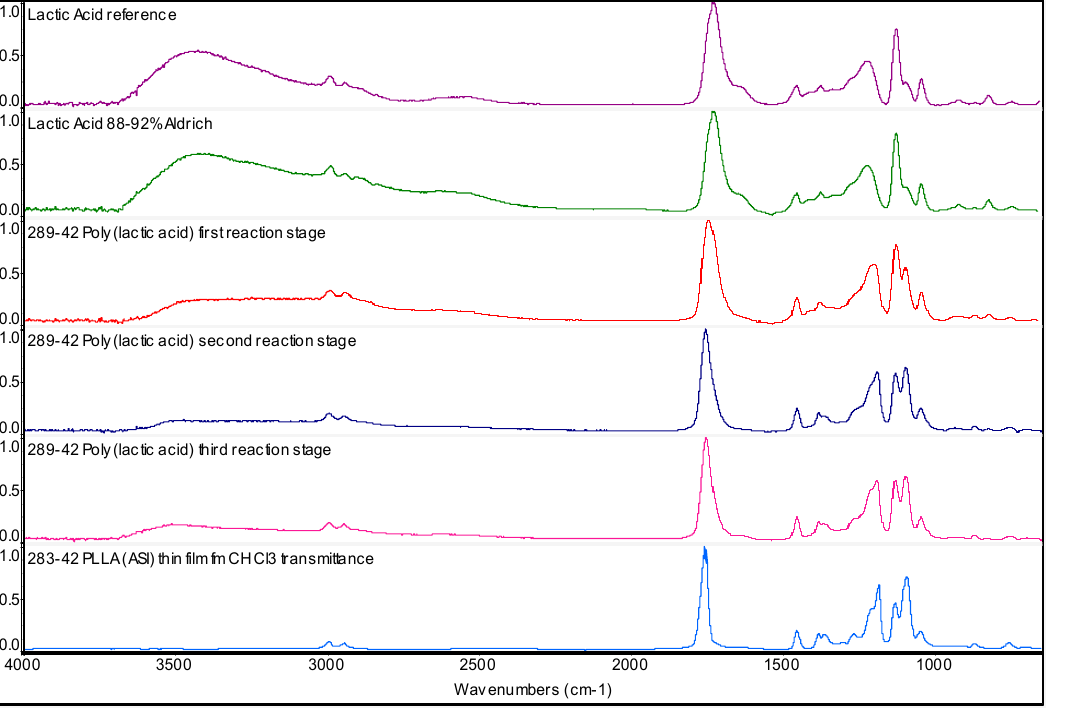
Figure 2. FT-IR spectra (from top to bottom): Lactic acid 100% (violet); Lactic acid 90% (green); PLAO first reaction stage (red); PLAO second reaction stage (dark blue); PLAO third reaction stage (amaranth); PLLA (ASI) high molecular weight reference polymer (light blue).